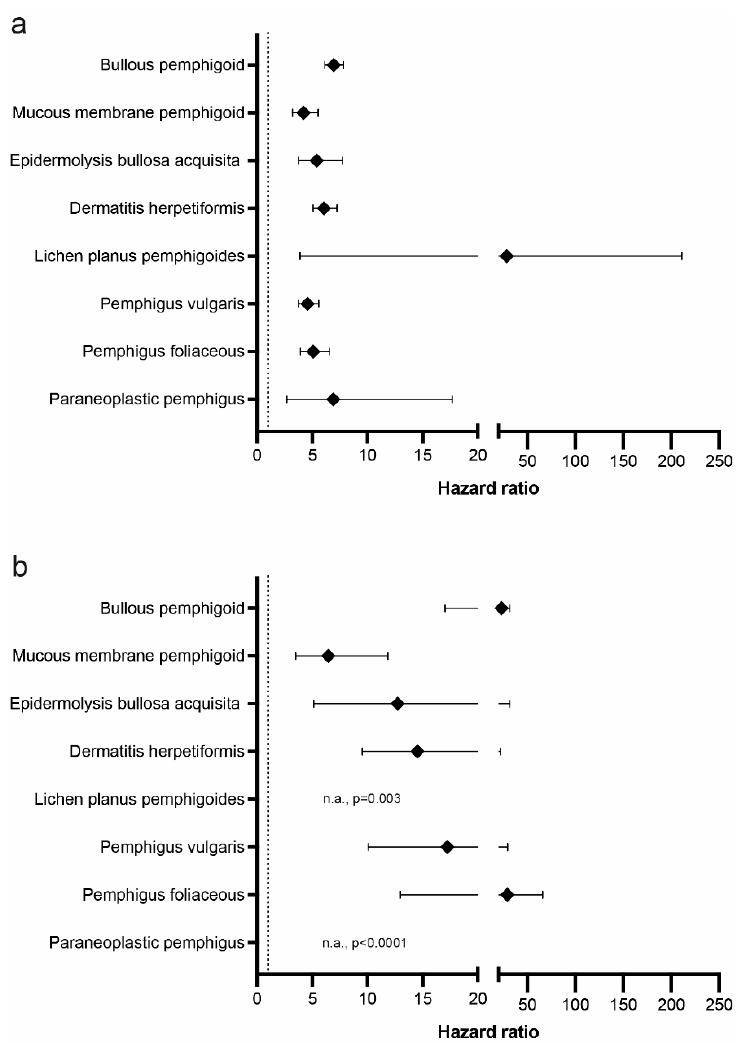
Figure 2. Hazard ratios for autoimmune bullous skin disease development in patients with pruritus. Data from the Global Collaborative Network of TriNetX were used to determine the risk of subsequent development of autoimmune bullous skin diseases (AIBDs). ( a ) Hazard ratio (HR) for development of the indicated AIBDs in patients diagnosed with pruritus compared with those without pruritus. Diamonds indicate HR; error bars indicate 5/95 confidence intervals. ( b ) Same analysis as in panel ( a ) but limiting follow ‐ up time after the diagnosis of pruritus to 6 months. Abbreviations: n.a.: not applicable.